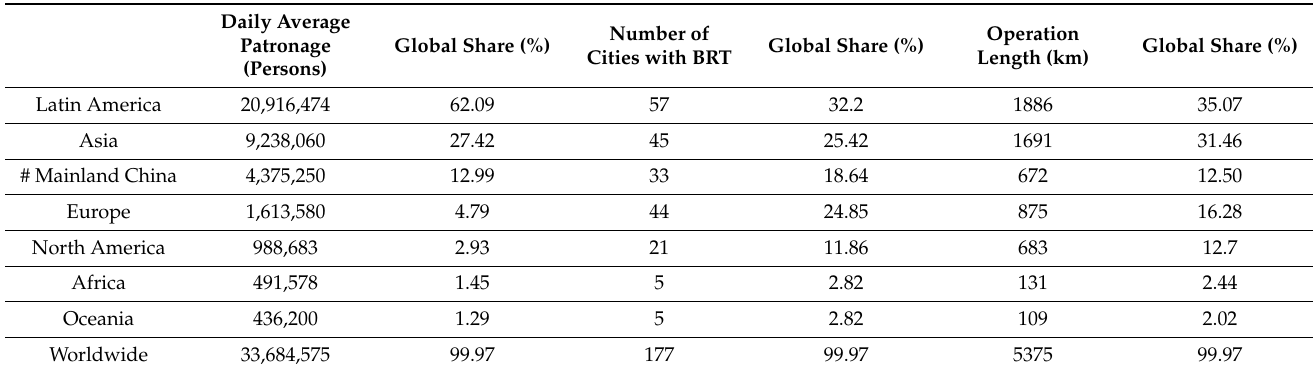
Table 1. Comparative analysis of global BRT by region in